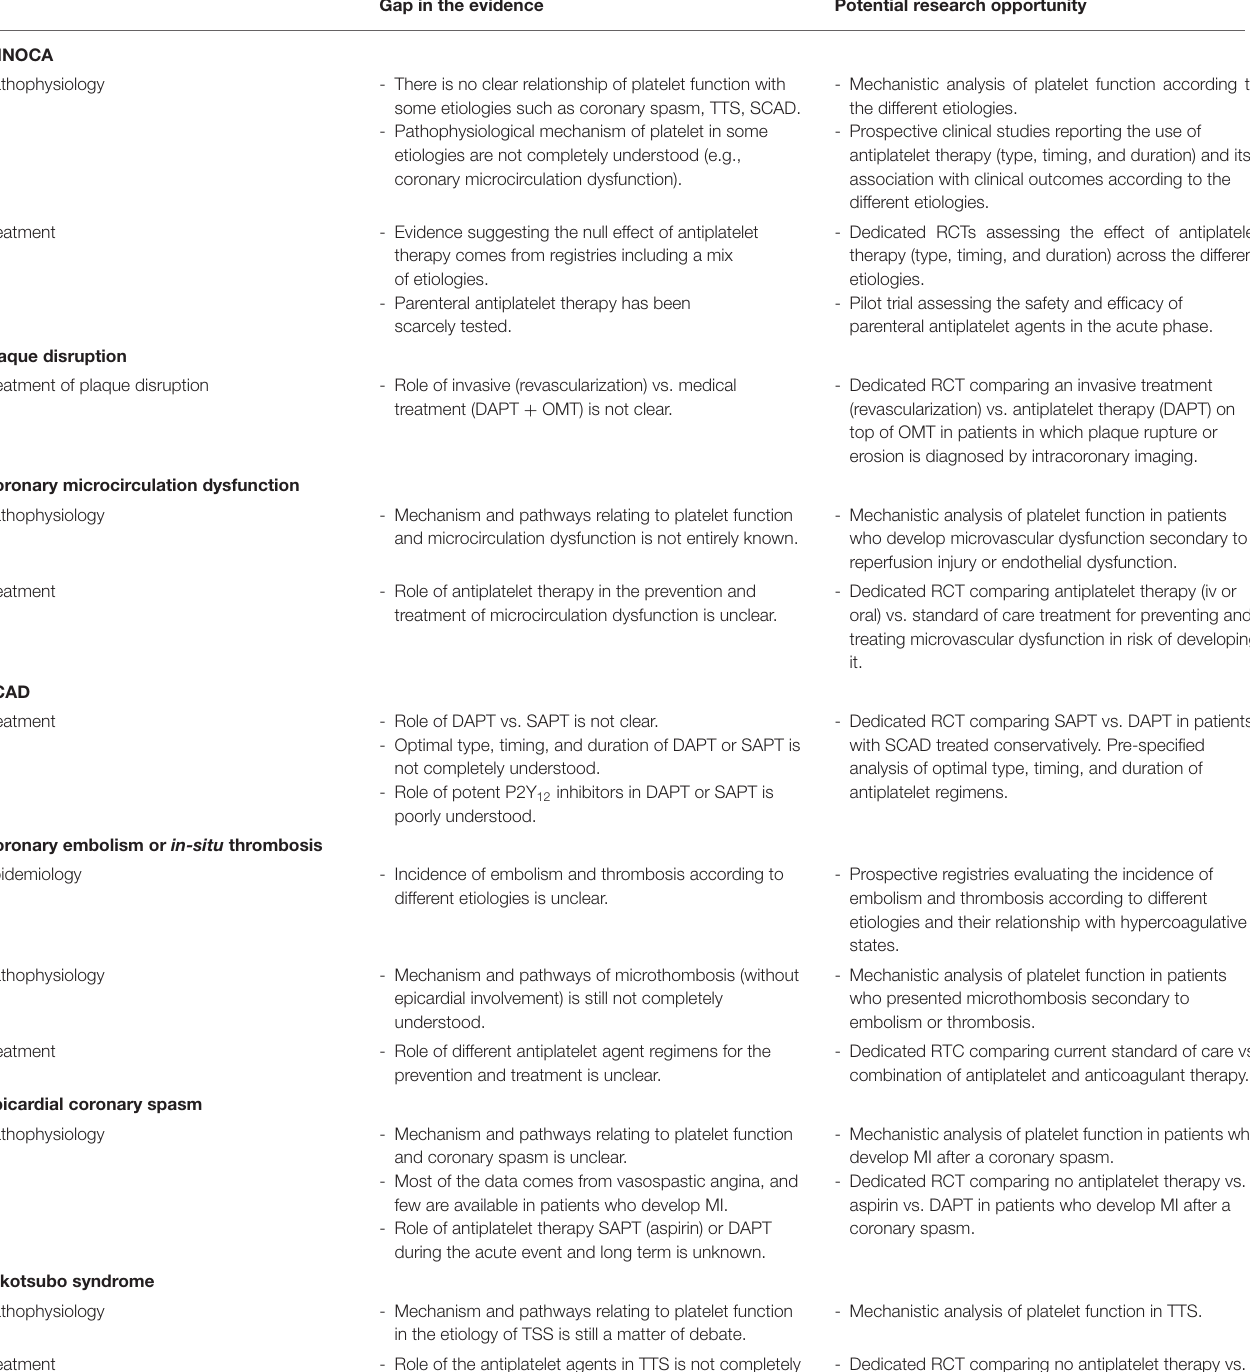
TABLE 3 | Current gaps in the evidence and potential research opportunities in the MINOCA